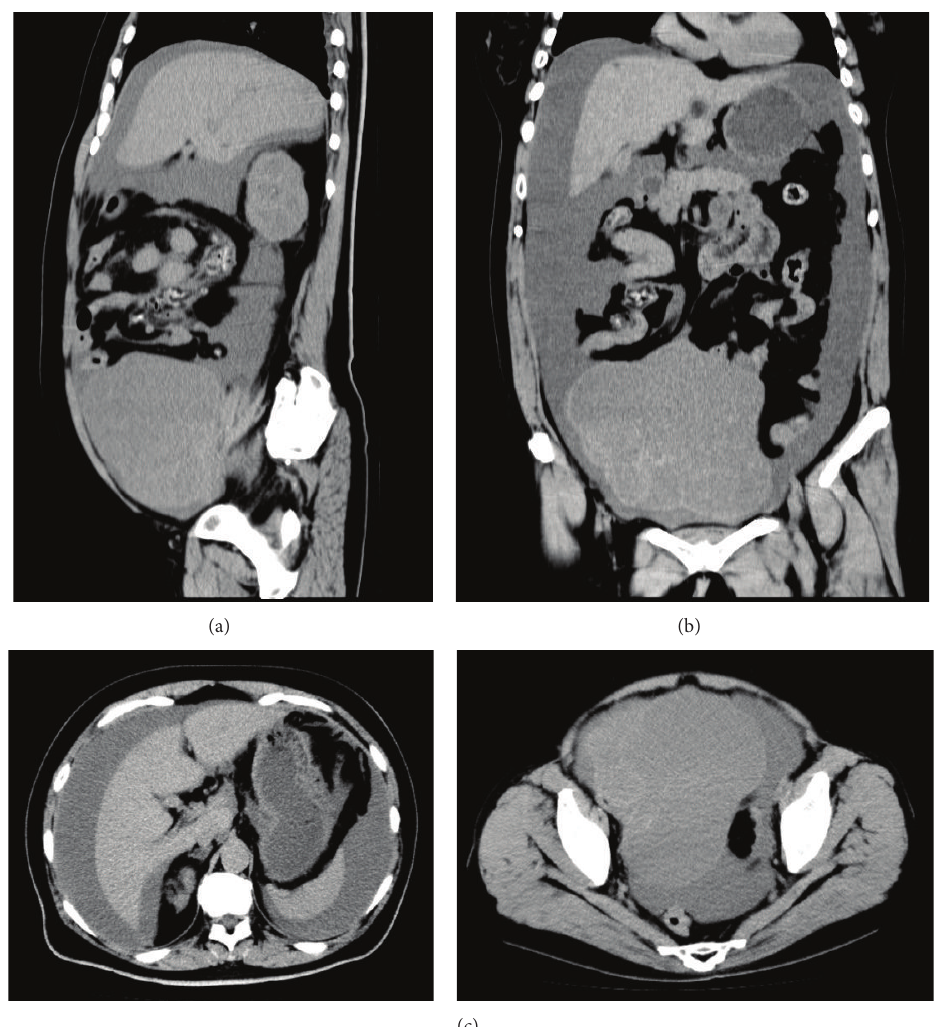
Figure 1: Abdominal plane computed tomography reveals a large pelvic mass with massive ascites that reach the liver and spleen. (a) Sagittal section; (b) frontal section; (c) coronal